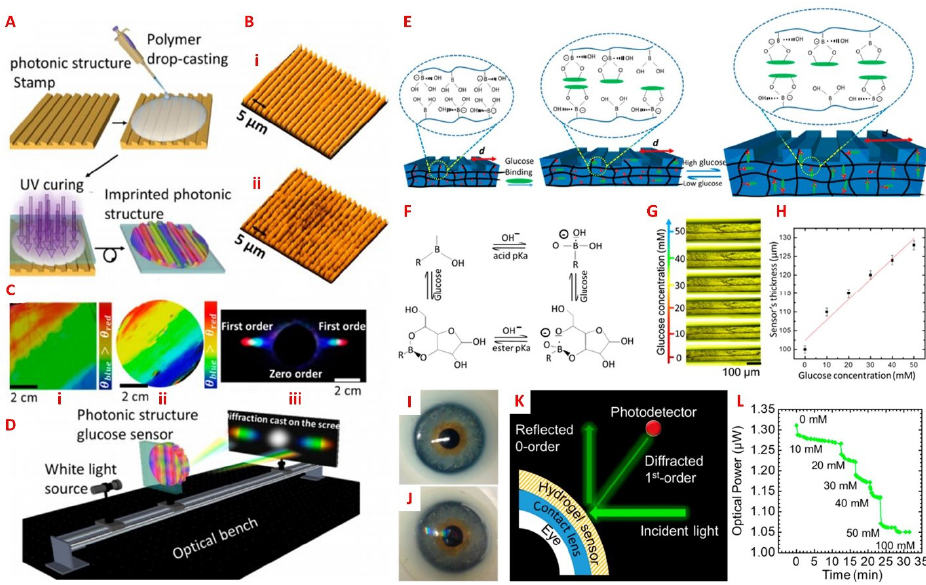
Figure 6. ( A ) Schematic of the fabrication process of a one‐dimensional hydrogel glucose sensor. The replica photonic structures are produced through drop‐casting and UV‐curing of monomer solutions on a master stamp. ( B ) Images of the (i) photonic structure stamp master and (ii) the imprinted hydrogel structure. ( C ) Images of (i) the original grating; (ii) the imprinted hydrogel sensor; and (iii)